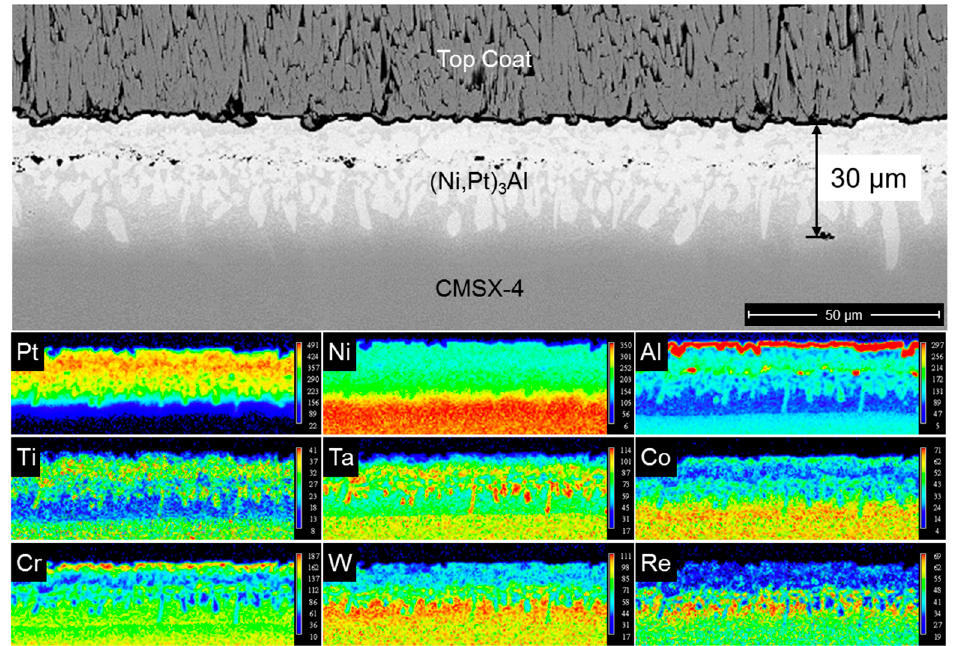
Figure 4. BSE imaging and EPMA mappings of the cross-section of a Pt-diffused γ / γ ’ bond coat. Table 1. Main phase and elements in the Pt-diffused γ / γ ’ bond coat. γ γ ’-Phase